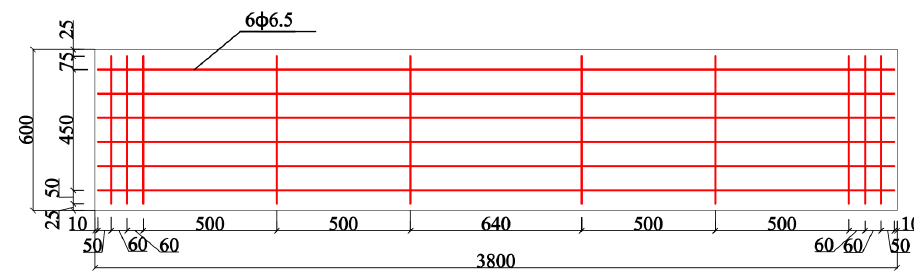
Figure 13. Details of the numerical model (units: mm). Table 2. Parameters of the concrete damaged plasticity model.